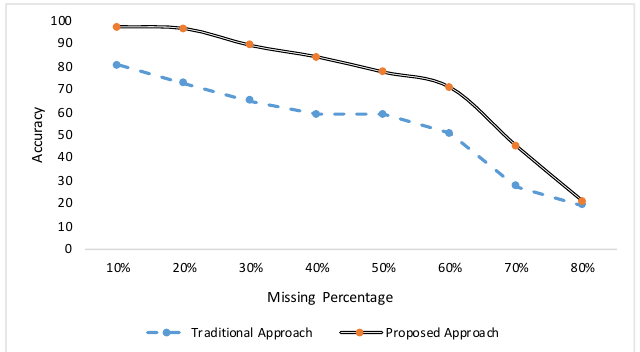
Figure 3. Recognition results for the simulated data with different data loss rates (from 10% to 80%). Traditional approach represents the results when the training data were clean while the testing data had missing patterns. Proposed approach demonstrates the results when both data had missing